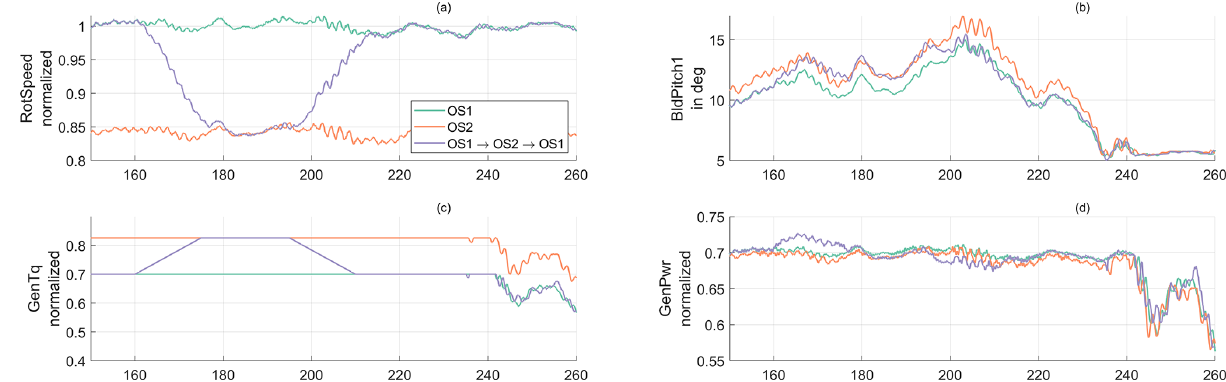
Figure 2. (a) Wind turbine rotational speed, (b) blade pitch angle, (c) generator torque, and (d) turbine power output in turbulent wind for OS1 and OS2 at 70% power production, where additionally a 15s ramp transition at 160s from OS1 to OS2 and back at 195s is shown.